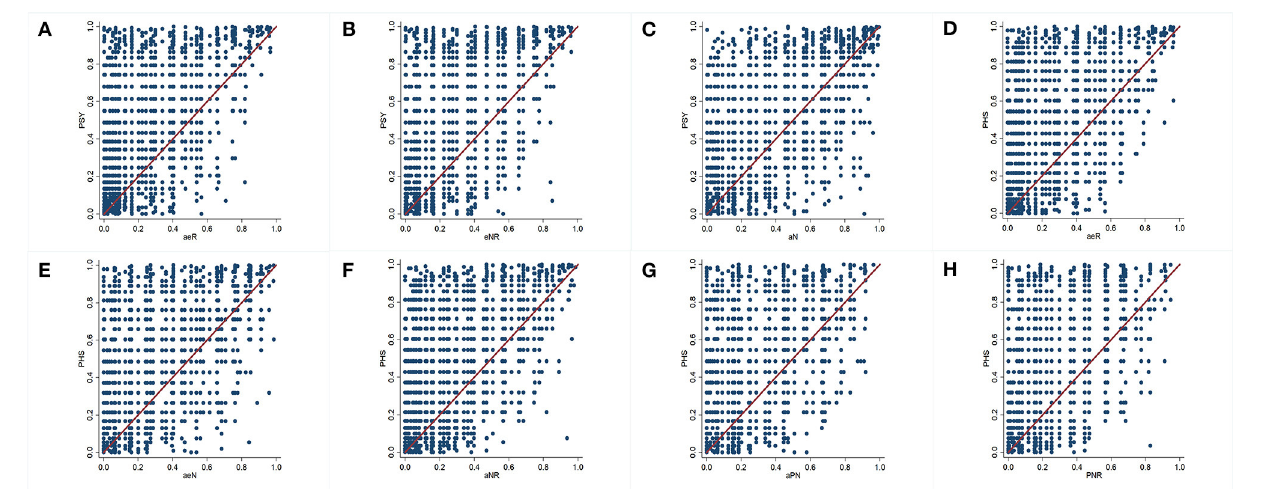
FIGURE 1 | Sufficiency and necessity graph between different factor sets for psychological strain (PSY) and physical strain (PHS). The horizontal axis represents factor sets, and the vertical axis represents PSY or PHS. (A) Set “a*e*R” is a sufficient but not necessary condition for PSY. In other words, set “a*e*R” is a fuzzy subset of PSY. (B) Set “e*N*R” is a sufficient but not necessary condition for PSY and a fuzzy subset of PSY. (C) Set “a*N” is a sufficient but not necessary condition for PSY and a fuzzy subset of PSY. (D) Set “a*e*R” is a sufficient but not necessary condition for PHS and a fuzzy subset of PHS. (E) Set “a*e*N” is a sufficient but not necessary condition for PHS and a fuzzy subset of PHS. (F) Set “a*N*R” is a sufficient but not necessary condition for PHS and a fuzzy subset of PHS. (G) Set “a*P*N” is a sufficient but not necessary condition for PHS and a fuzzy subset of PHS. (H) Set “P*N*R” is a sufficient but not necessary condition for PHS and a fuzzy subset of PHS. E/e, extroversion/introversion; N/n, stronger emotional reactions such as anxiety, worry, and even irrational behavior/weaker emotional reactions; P/p, loneliness, indifference, and difficulty adapting to the external environment/normal; R/r, self-perceived high work pressure/self-perceived acceptable work pressure; A/a, stronger psychological flexibility/weaker psychological